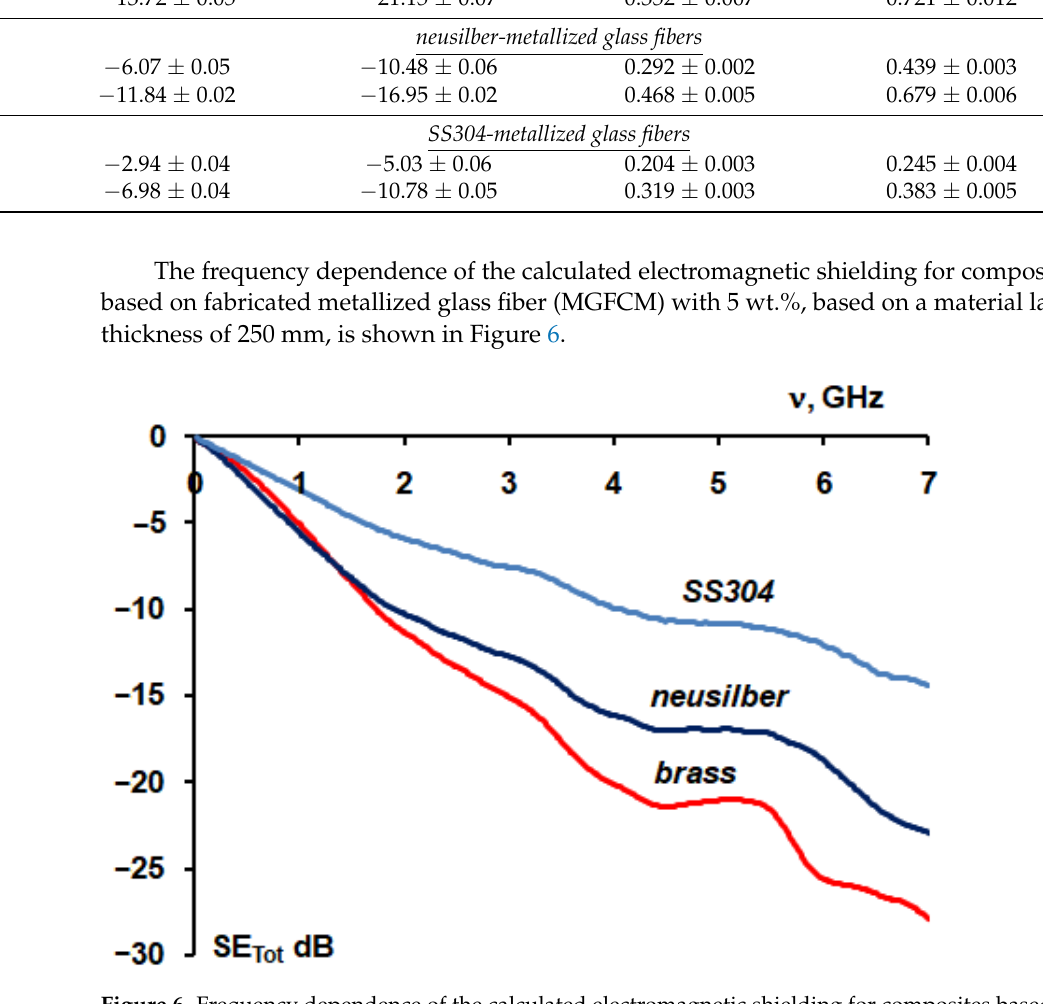
Figure 5. Total shielding effectiveness, shielding effectiveness due to absorption and shielding ef- fectiveness due to reflection of metallized glass fiber composites: ( a ) with brass film; ( b ) with neusil- ber film; ( с ) with SS304 film.